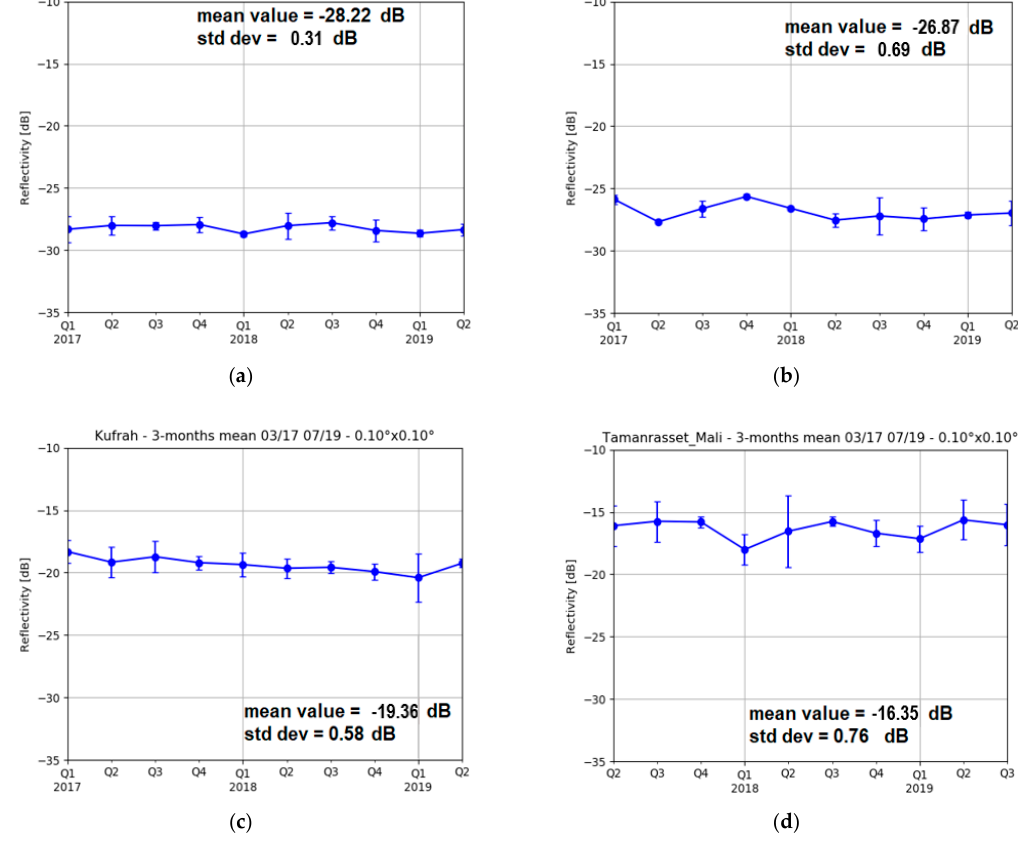
Figure 3. Temporal variations of CYGNSS reflectivity over a period of 2.5 years: ( a ) Algerian dunes, ( b ) Egypt dunes, ( c ) Kufrah (Libya), ( d )